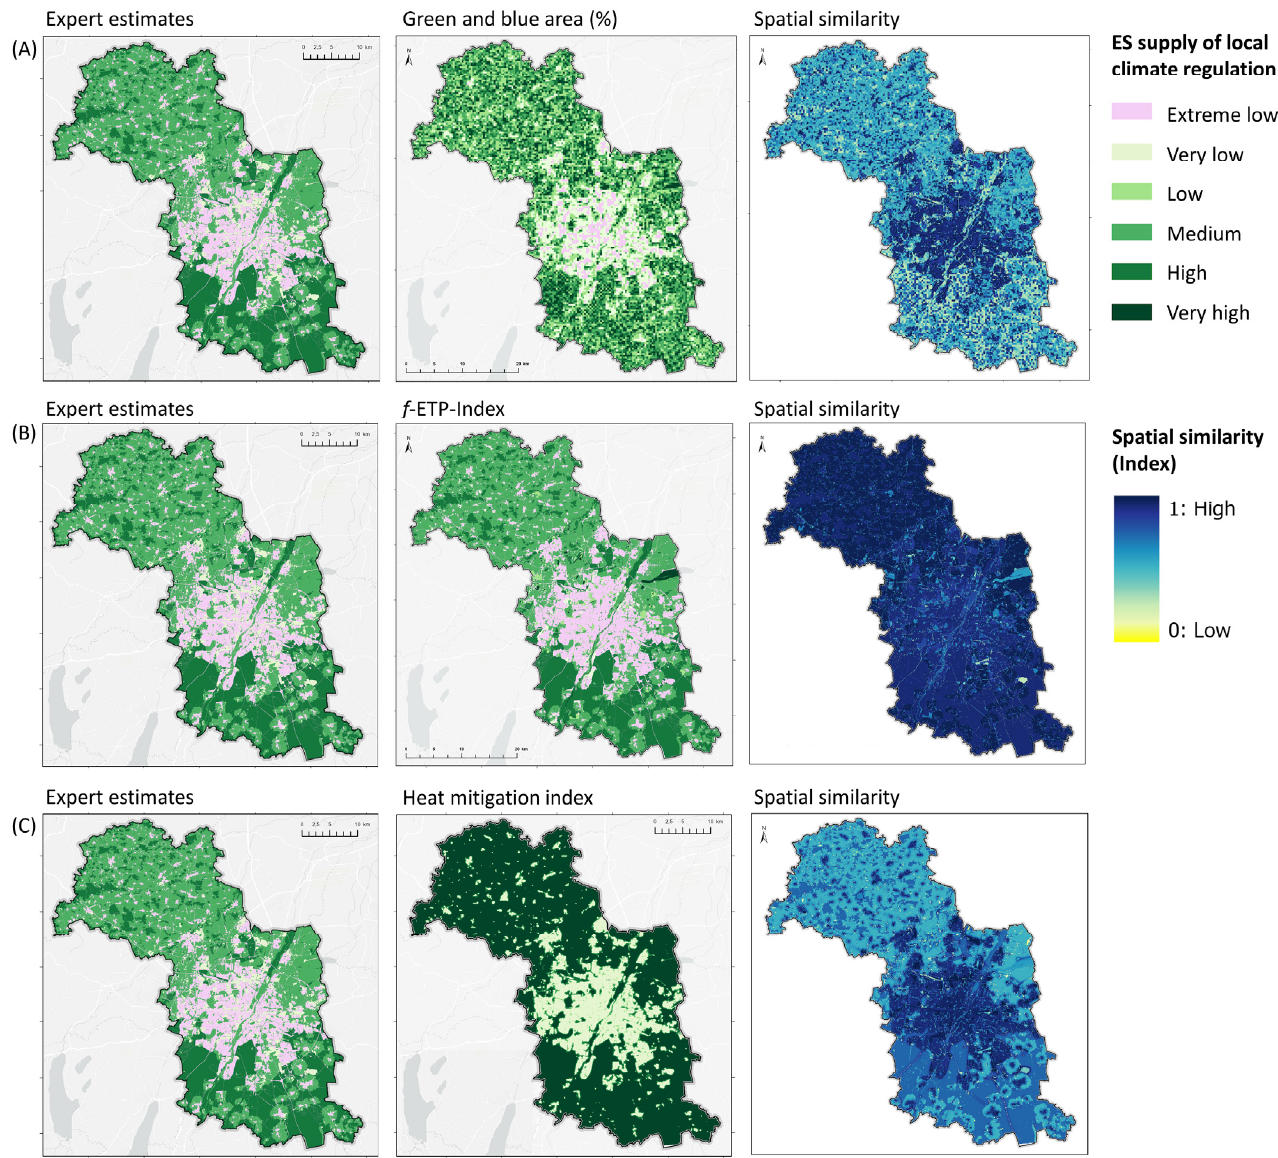
Figure 6. Map comparisons between the expert estimates (expert-based ES matrix approach) and the indicators ( A ) green and blue area (%) (LULC data); ( B ) f -ETP-Index (literature data); ( C ) heat mitigation index (InVEST model Urban Cooling). The highest spatial similarity value (1) is shown in dark blue, and the lowest (0) is in yellow.